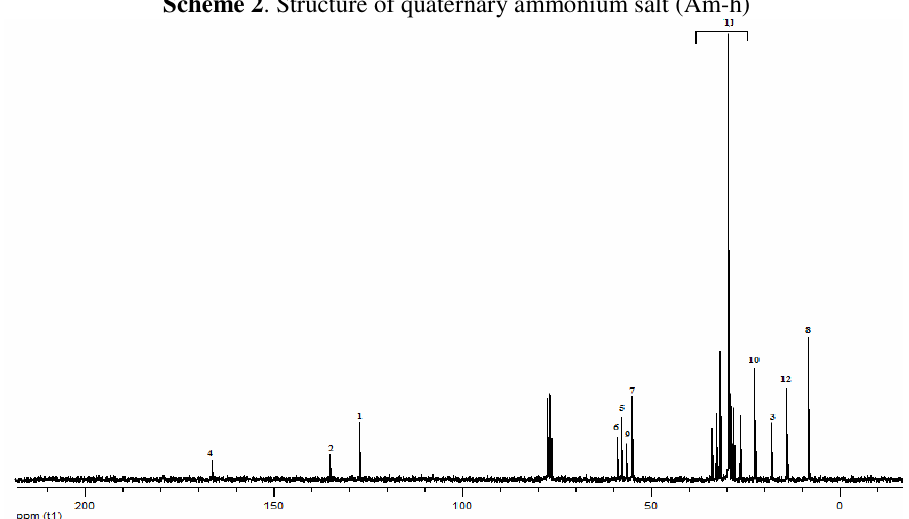
Figure 3. 13 C NMR spectra of